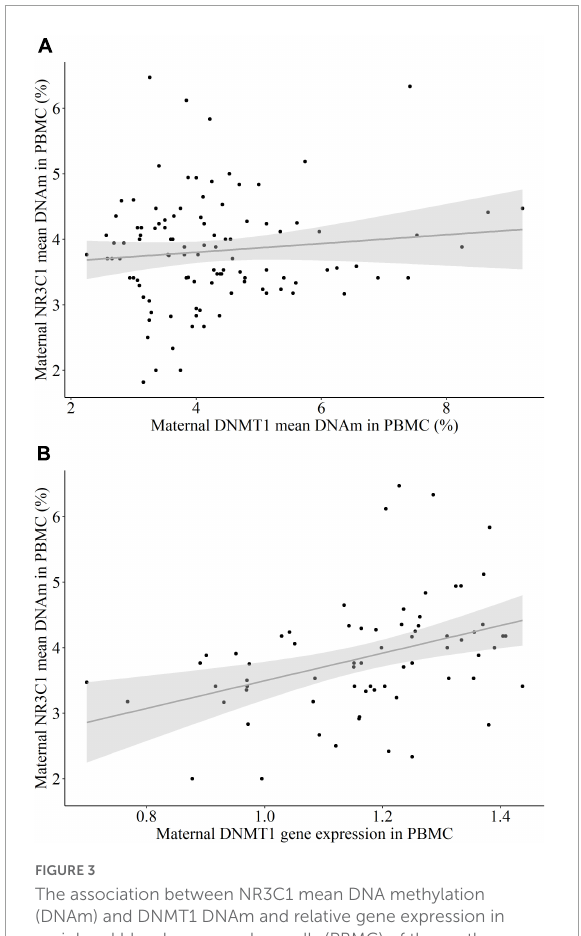
FIGURE3 The association between NR3C1 mean DNA methylation (DNAm) and DNMT1 DNAm and relative gene expression in peripheral blood mononuclear cells (PBMC) of the mothers. (A) DNMT1 mean DNAm did not have a significant correlation with NR3C1 exon 1F mean DNAm ( r s = 0.031, p = 0.752). (B) DNMT1 relative gene expression had a positive correlation with NR3C1 exon 1F mean DNAm ( r s = 0.444, p <